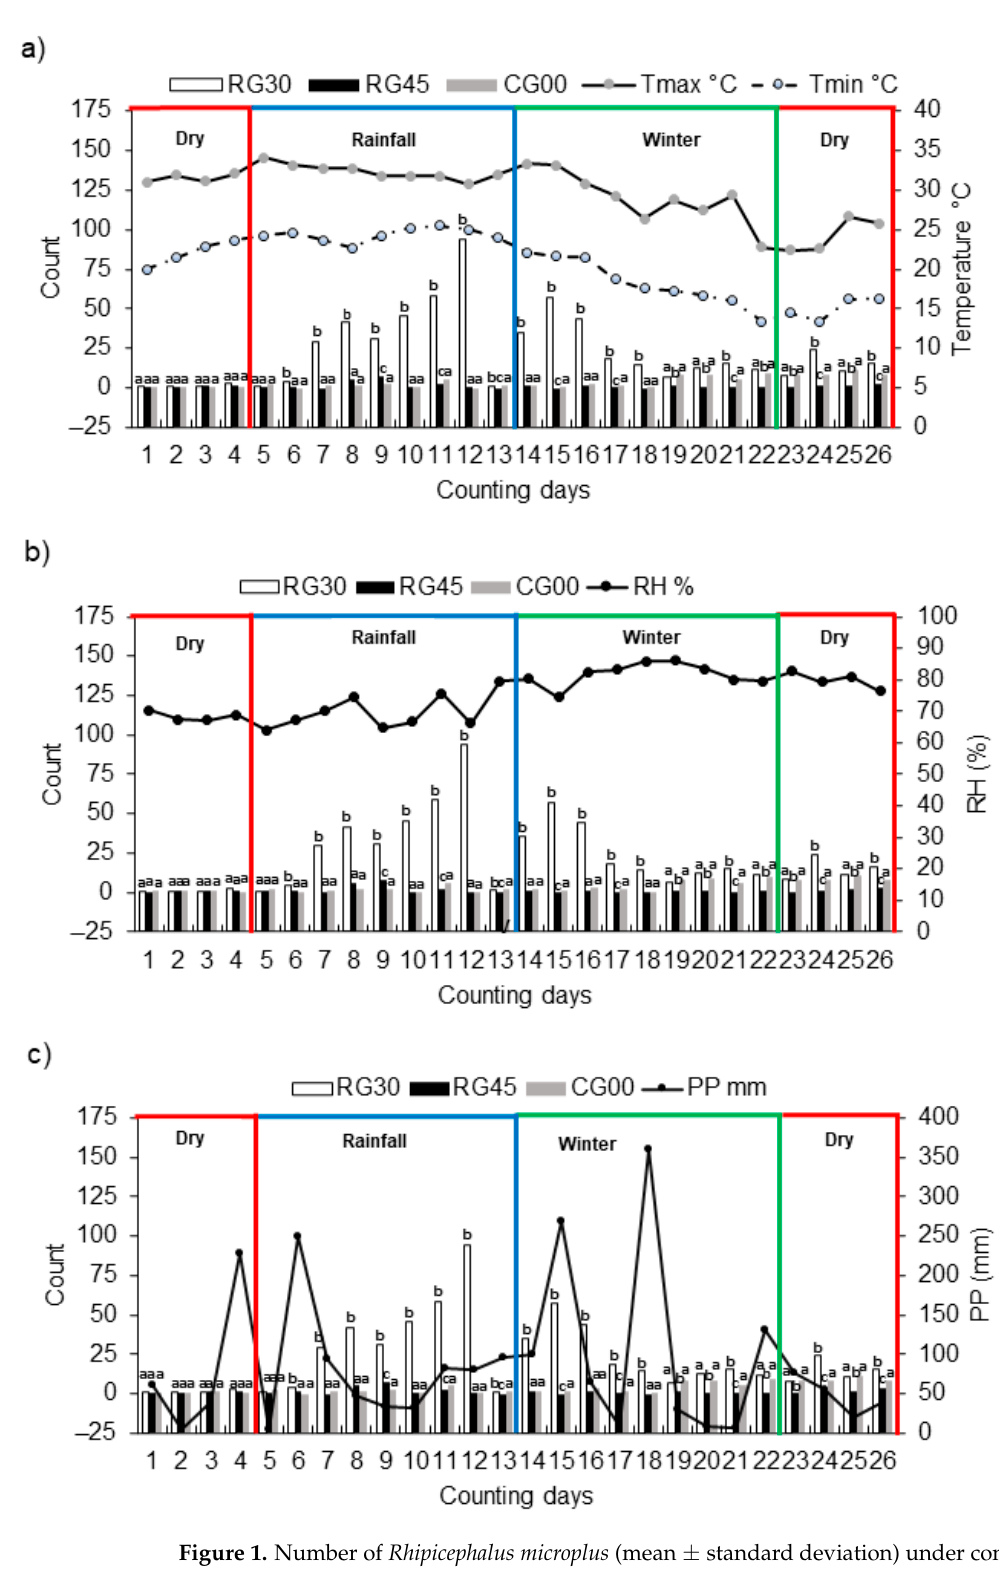
Figure 1. Number of Rhipicephalus microplus (mean ± standard deviation) under continuous grazing (CG00), rotational grazing with 30 and 45 days of rest (RG30 and RG45, respectively) on cattle (n = 10 per treatment), for 1 year (April 2021 to March 2022). Tmax = maximum temperature in ◦ C; Tmin = minimum temperature in ◦ C ( a ), ◦ C = degrees centigrade, RH = relative humidity (%) ( b ), PP = pluvial precipitation (mm) ( c ). Within dates, bars with the same upper script letter are statistically equal at p < 0.05.